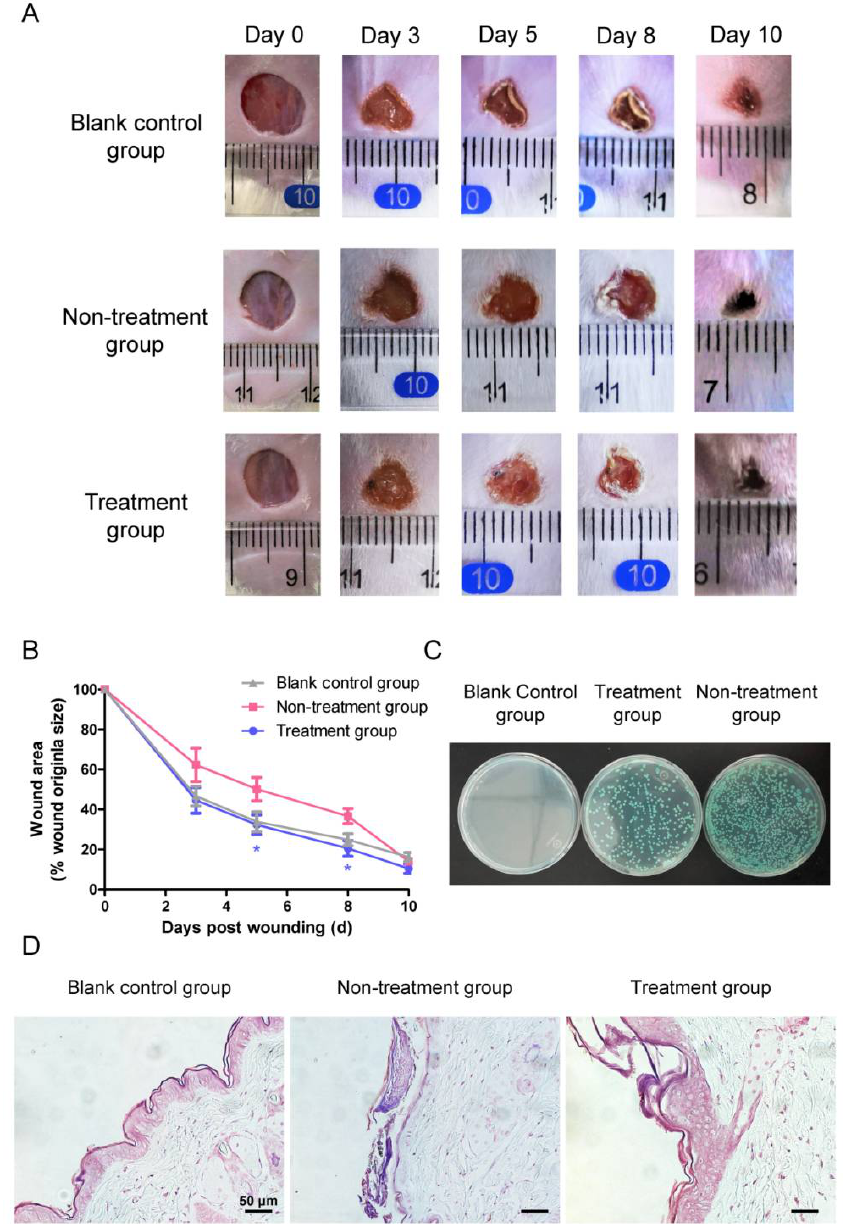
Figure 8. In vivo antifungal action of AP10W for C. albicans -infected wound in mice. ( A ) Repre- sentative photographs of wounds at 0, 3, 5, 8, and 10 days post wound. Blank control group: no C. albicans -infected, no treatment; Non-treatment group: C. albicans -infected; sterile saline treatment; Treatment group: C. albicans -infected; AP10W (8 µ g/mL) treatment. Infection wounds with AP10W treatment showed accelerated healing compared to the infection group. ( B ) The area of the wounds was quantified by ImageJ software over multiple time points. Values represent means ± SEM (n = 7/group). Statistical differences between the treatment group and non-treatment group were assessed using unpaired t-test, * p < 0.05. ( C ) Different groups of wound skin tissue suspension were cultured in the chromogenic screening medium. C. albicans appeared as green smooth colonies. ( D ) Evaluation of wound by Gram staining of tissues. Wound skin tissue sections of three groups (blank control, non-treatment and treatment group) were Gram stained on day 3 (n = 2). Gram- positive C. albicans are indicated by purple. C. albicans were reduced in treatment group compared to the infection group. Scale bars: 50 µ